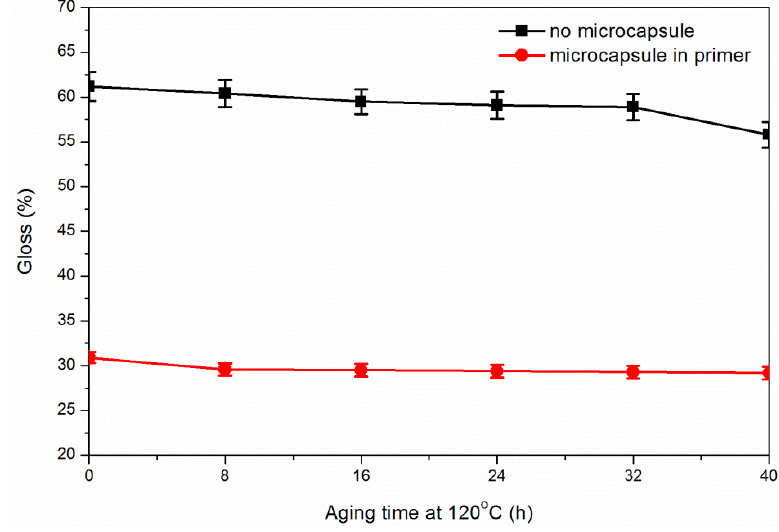
Figure 9. E ff ect of aging time on gloss of paint film in the 120 ◦ C Figure 9. Effect of aging time on gloss of paint film in the 120 °C oven.